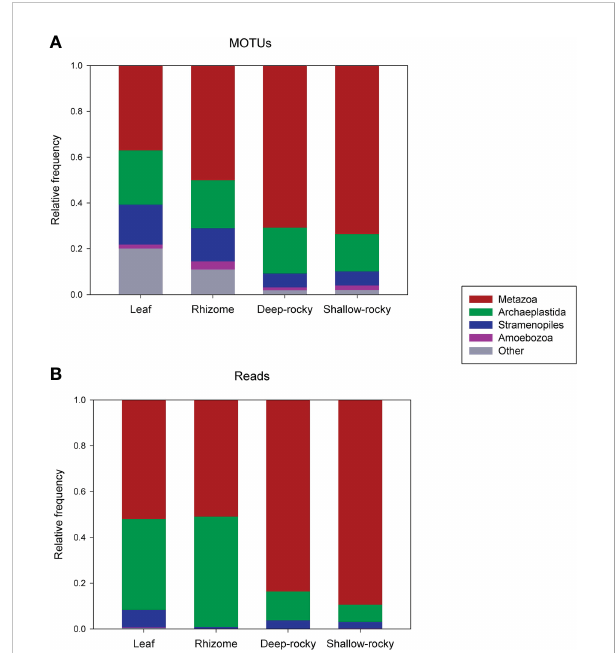
FIGURE 1 (A) , proportion of the assigned MOTUs that belong to the main Super-Groups of Eukarya considered; (B) , proportion of reads represented by these Super-Groups.